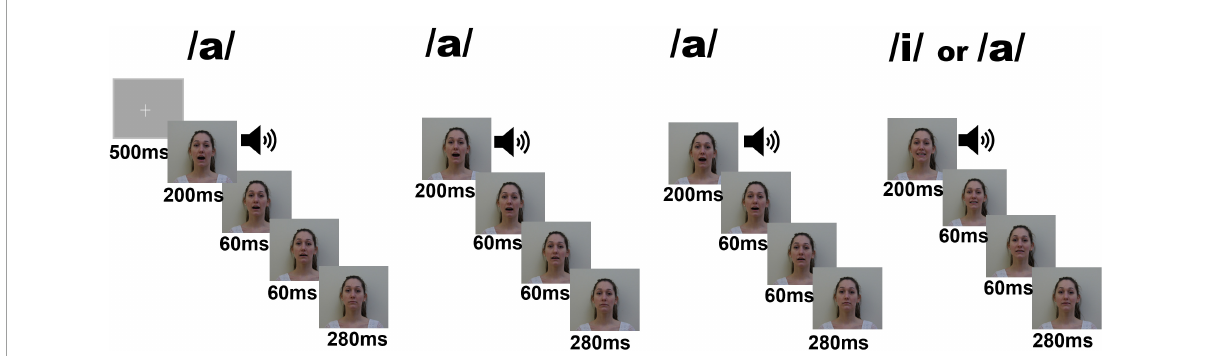
FIGURE1 Schematic description of the experimental electrophysiological task. One trial consisted of a sequence of three times the vowel/a/followed by a standard/i/(80 times) or a deviant/a/(16 times). Auditory presentations were supported by visual images (faces pronouncing the vowels). Auditory stimuli were presented during the first 200 ms of each sequence.